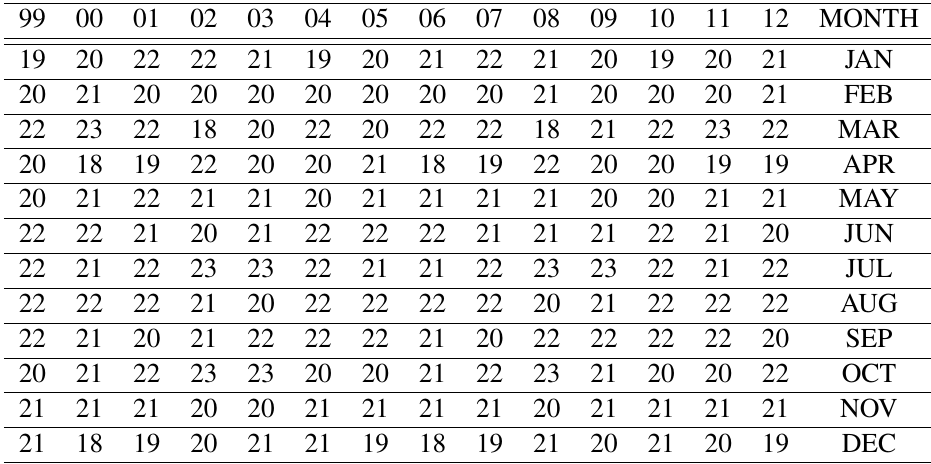
Table 8 Number of working days per year and month throughout the period of study 1999-2012 for construction companies (Monday to Friday included). Source: own elaboration from “Diario Oficial de Castilla-La Mancha” (Spain) and “Convenios Generales del Sector de la Construcción en